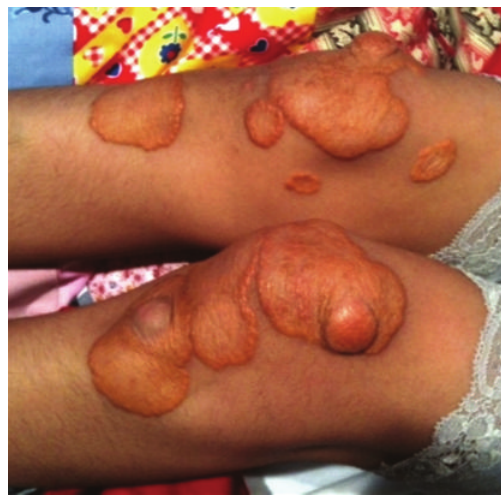
Figure 3: Cutaneous xanthomas on the knees of patient no.